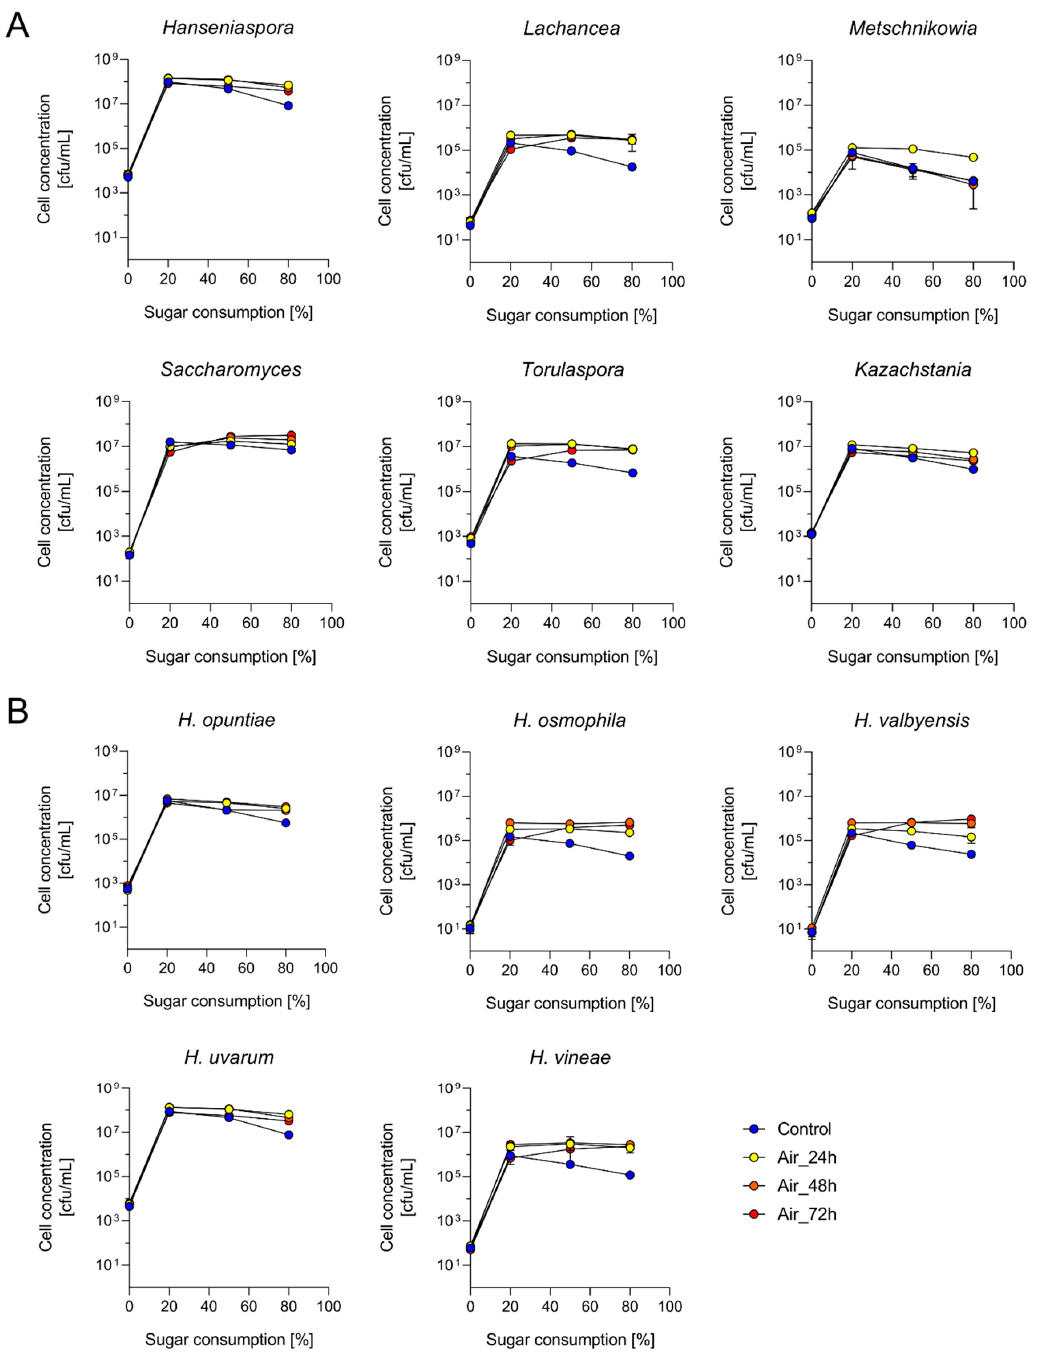
Figure 4. Estimated yeast counts for the main genera ( A ) and for Hanseniaspora species ( B ) found in ferments from the 2019 vintage. All symbols show means of three treatments with error bars showing SD.